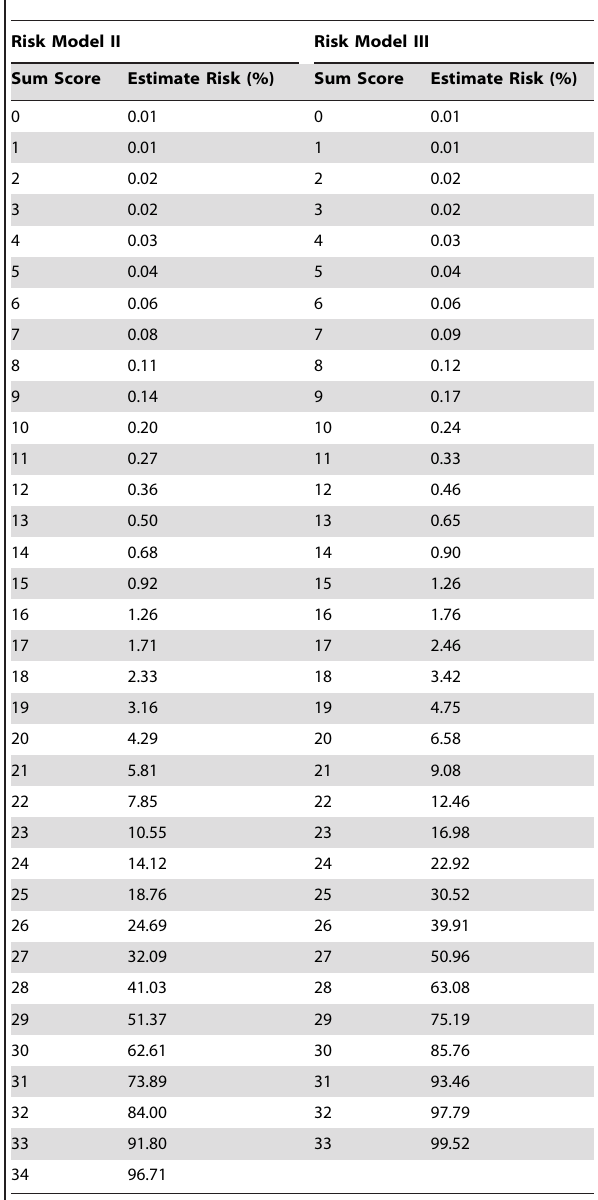
Table 3. Estimated 6-year Incidence of Hepatocellular Carcinoma Using Risk Models Combining Liver-related Seromarkers without (Model II) and with (Model III) HBV Seromarkers of HBeAg Serostatus and Serum HBV DNA